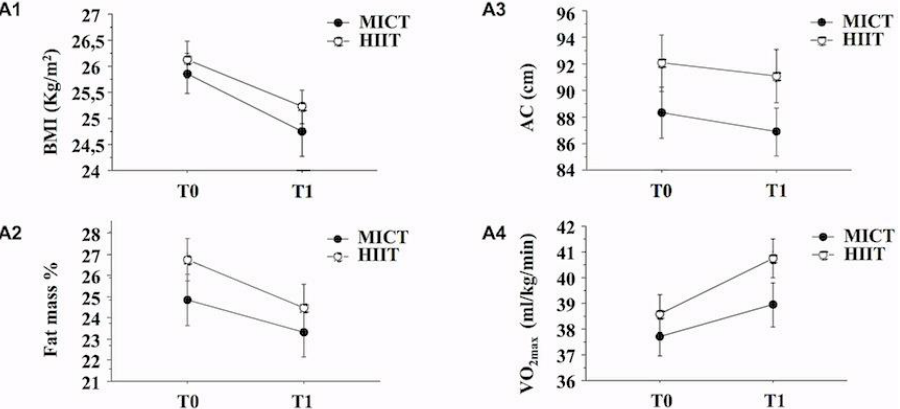
Figure 1. Effects of moderate intensity continuous training (MICT) and HIIT protocol on BMI, Abdominal Circumference (AC), Fat mass percentage and VO 2max . (A1–A4): Line charts report two-way ANOVA with repeated measures at baseline (T0) and after 6 weeks of training (T1) with BMI ( A1 ), Body Fat mass percentage ( A2 ), Abdominal circumference, AC ( A3 ) and VO 2max ( A4 ) as dependent variables. All values are expressed as the mean ± SE. No significant interaction ( p > 0.05) between training and time (training × time interaction) for all parameters analyzed were found.